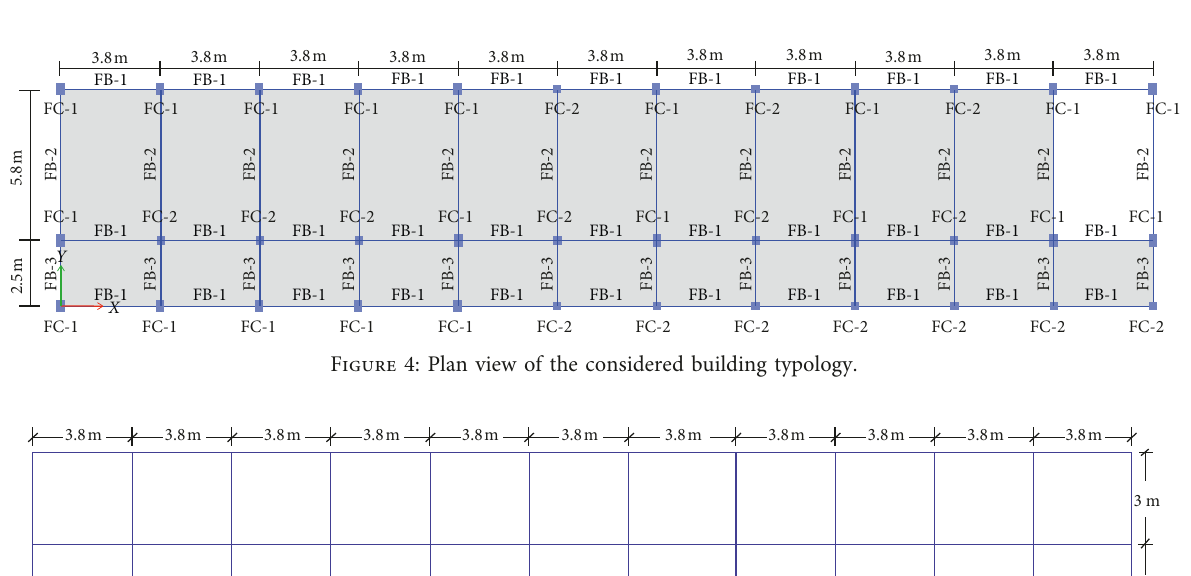
Figure 3: Framework for the vulnerability assessment of RC school buildings in the current study.